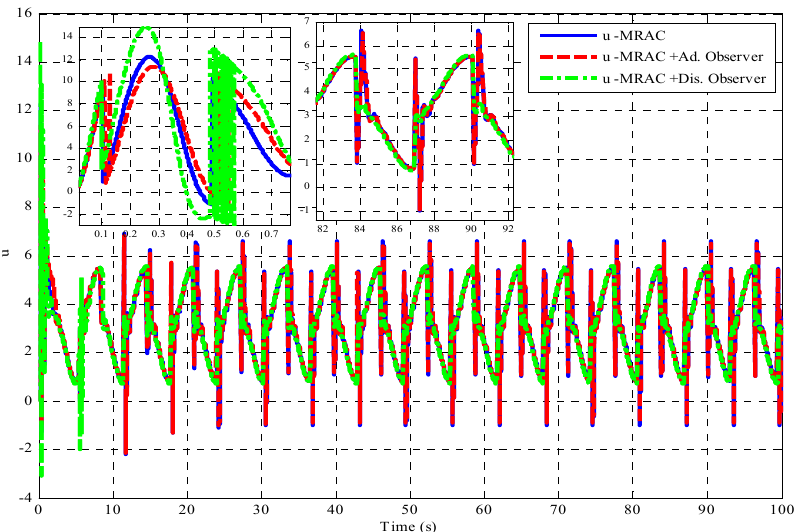
Figure 7. Control action for the three controllers.